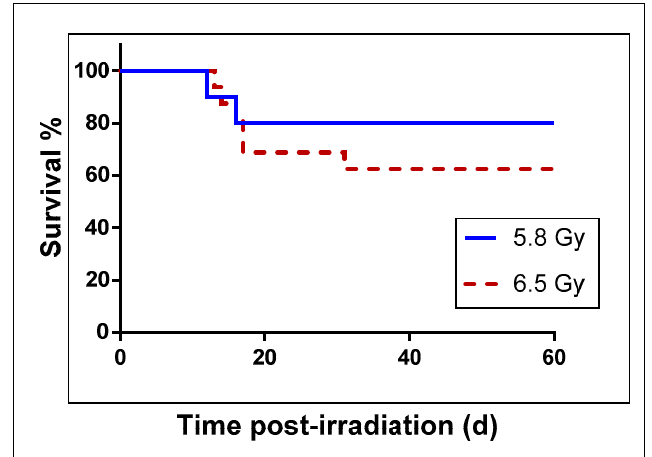
Figure 2. Survival curve for nonhuman primates (NHPs) exposed to 5.8 Gy (LD 20 − 40/60 ) or 6.5 Gy (LD 30 − 50/60 ) total-body 60 Co γ -radiation. NHPs were exposed to a specific radiation dose at a dose rate of 0.6 Gy/min (bilateral, simultaneous) and observed for 60 d for survival.